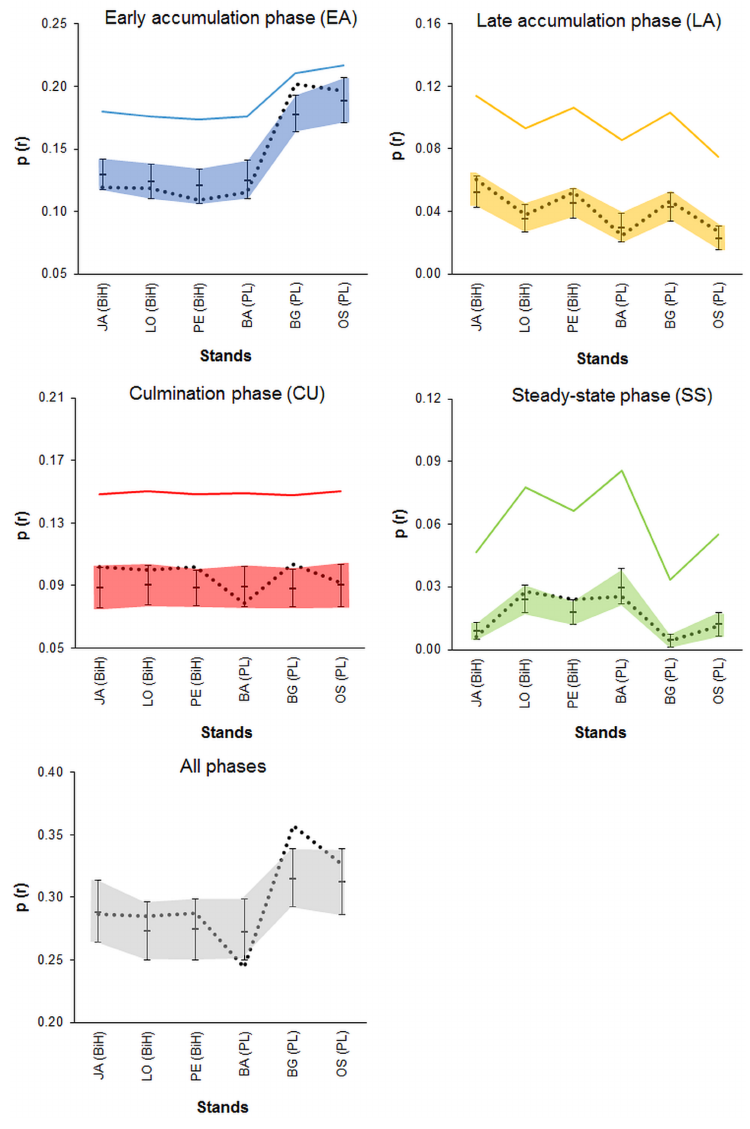
Figure 11. Testing of the spatial independence of the phase distribution in six Abies–Picea–Fagus stands: mark connection function p(r) for the empirical distributions (dotted lines) and 95% envelopes (shaded areas) obtained from random labeling simulations for the eight nearest-neighbor cells (3 × 3 cells, spatial scale 40 m × 40 m = 1600 m 2 ). The empirical values above the envelopes indicate positive spatial correlations of the classification outputs (aggregation = overrepresentation compared to random labeling), and the values below the envelopes indicate negative spatial correlations (segregation compared to random labeling). The solid lines point out the expected values of the p(r) for the pattern in which half of the neighboring eight plots represent the same phase as the central